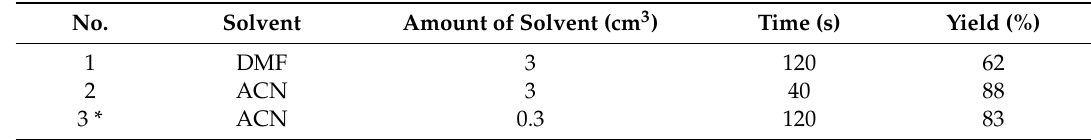
Table 3. Synthesis 1-(3-chloropropyl)-4-(3-chlorophenyl)piperazine ( 5 )—26 mmol of 1-bromo-3- chloropropane ( 2a ), 10 mmol of 1-(3-chlorophenyl) piperazine hydrochloride ( 4 ), 10 mmol of TBAB, 30 mmol of K 2 CO 3 .